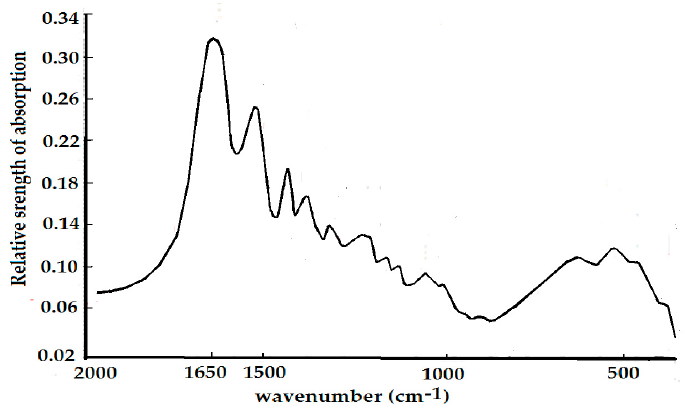
Figure 11. Infrared spectrum of absorption of collagen in 480–2000 cm − 1 .